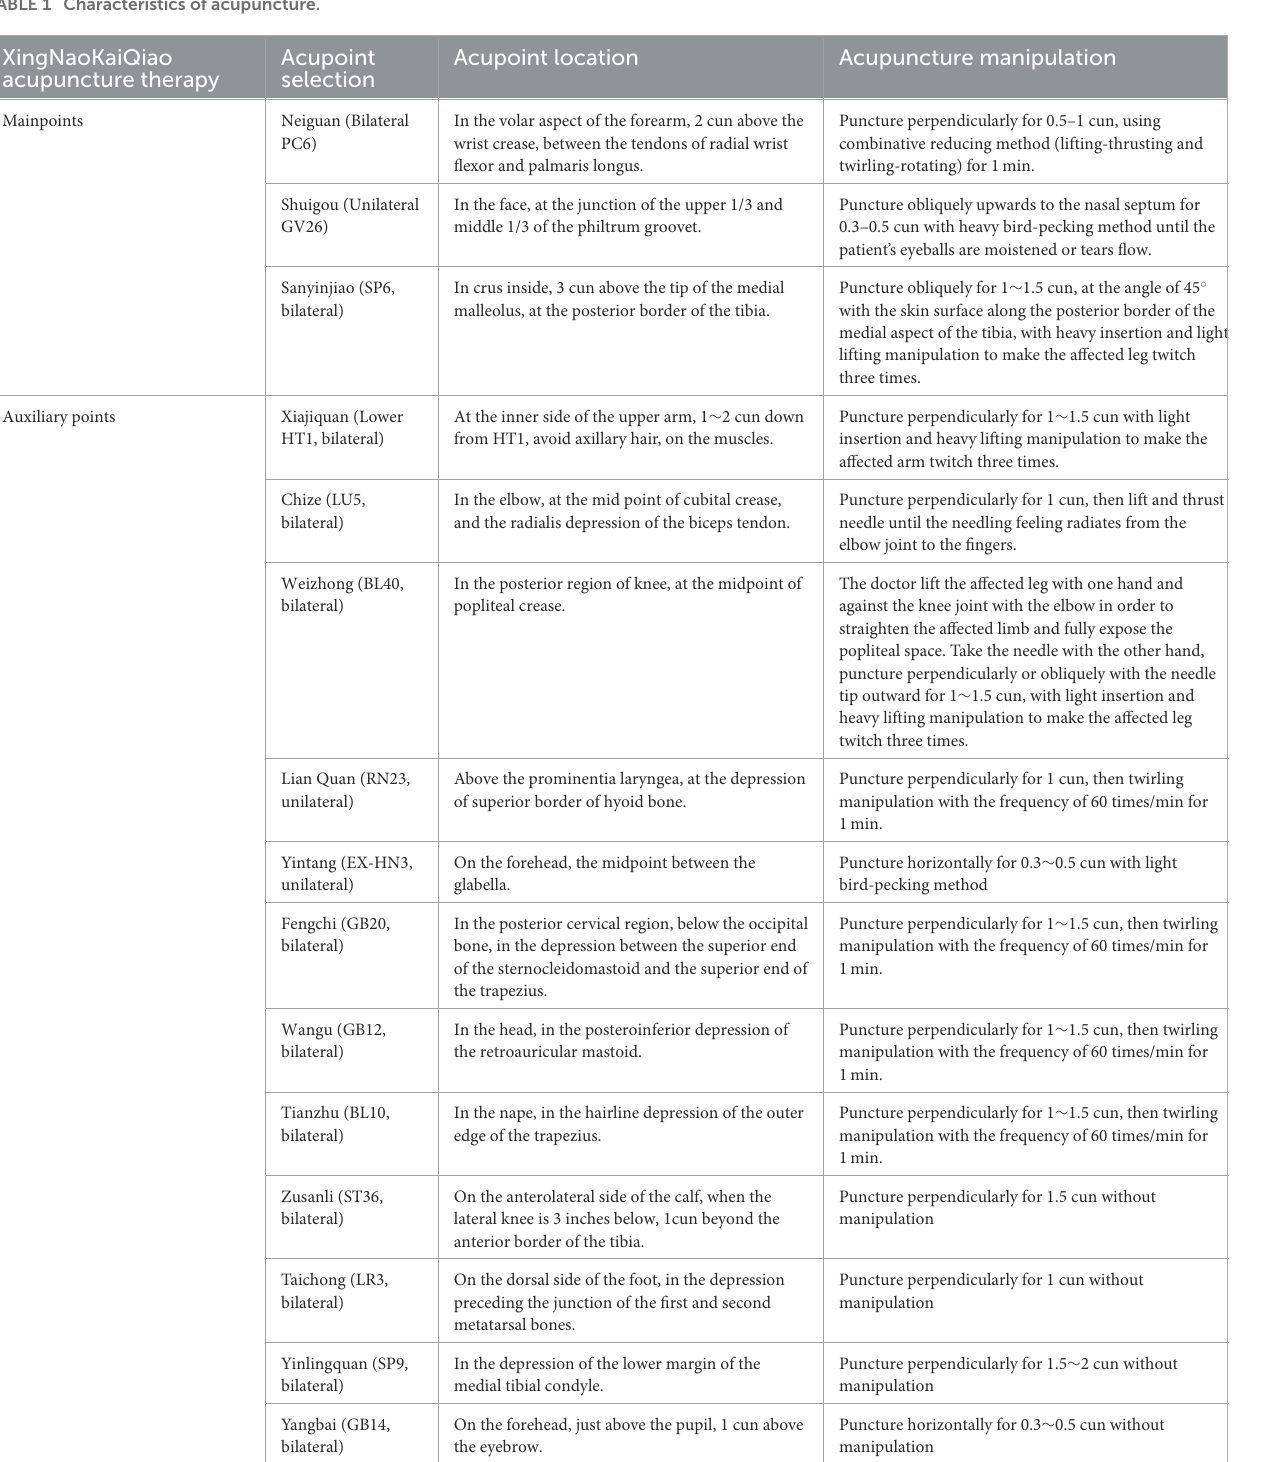
TABLE 1 Characteristics of